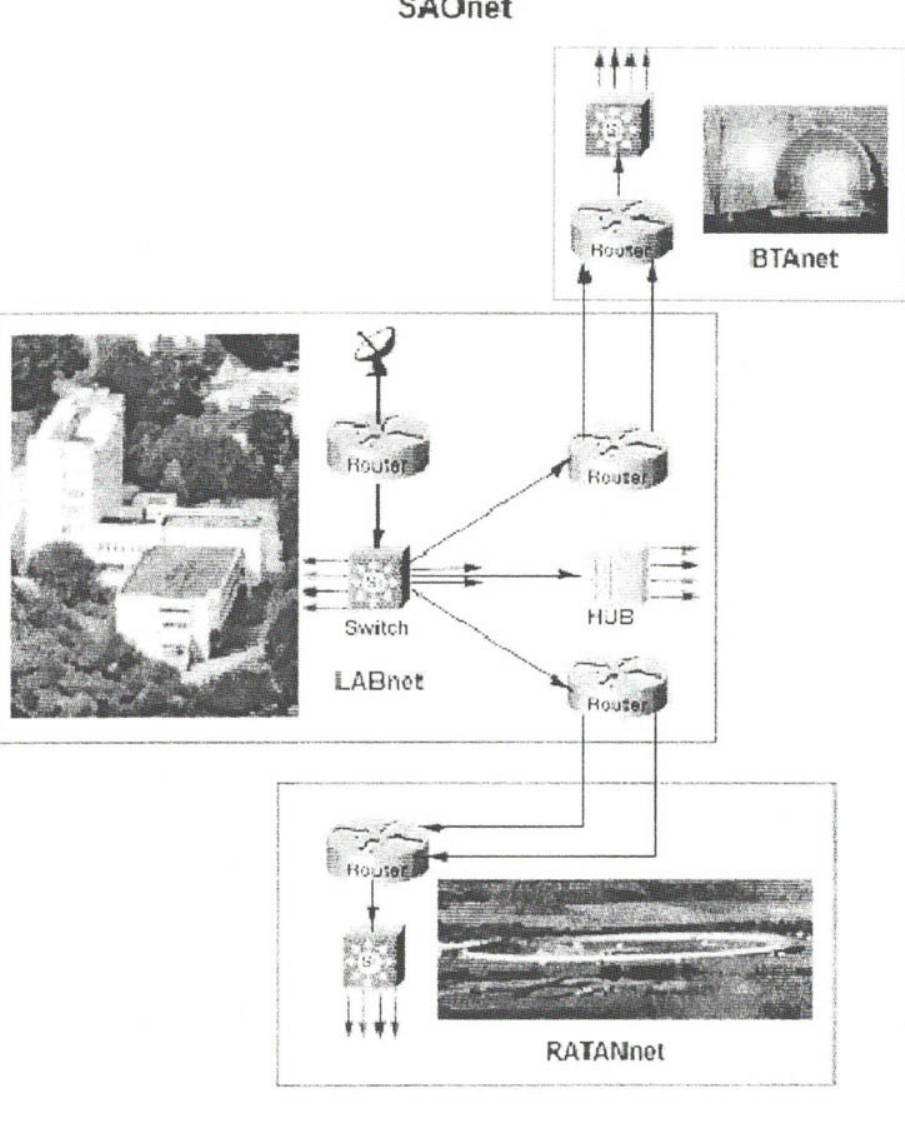
Fig. 1. The information network of SAO